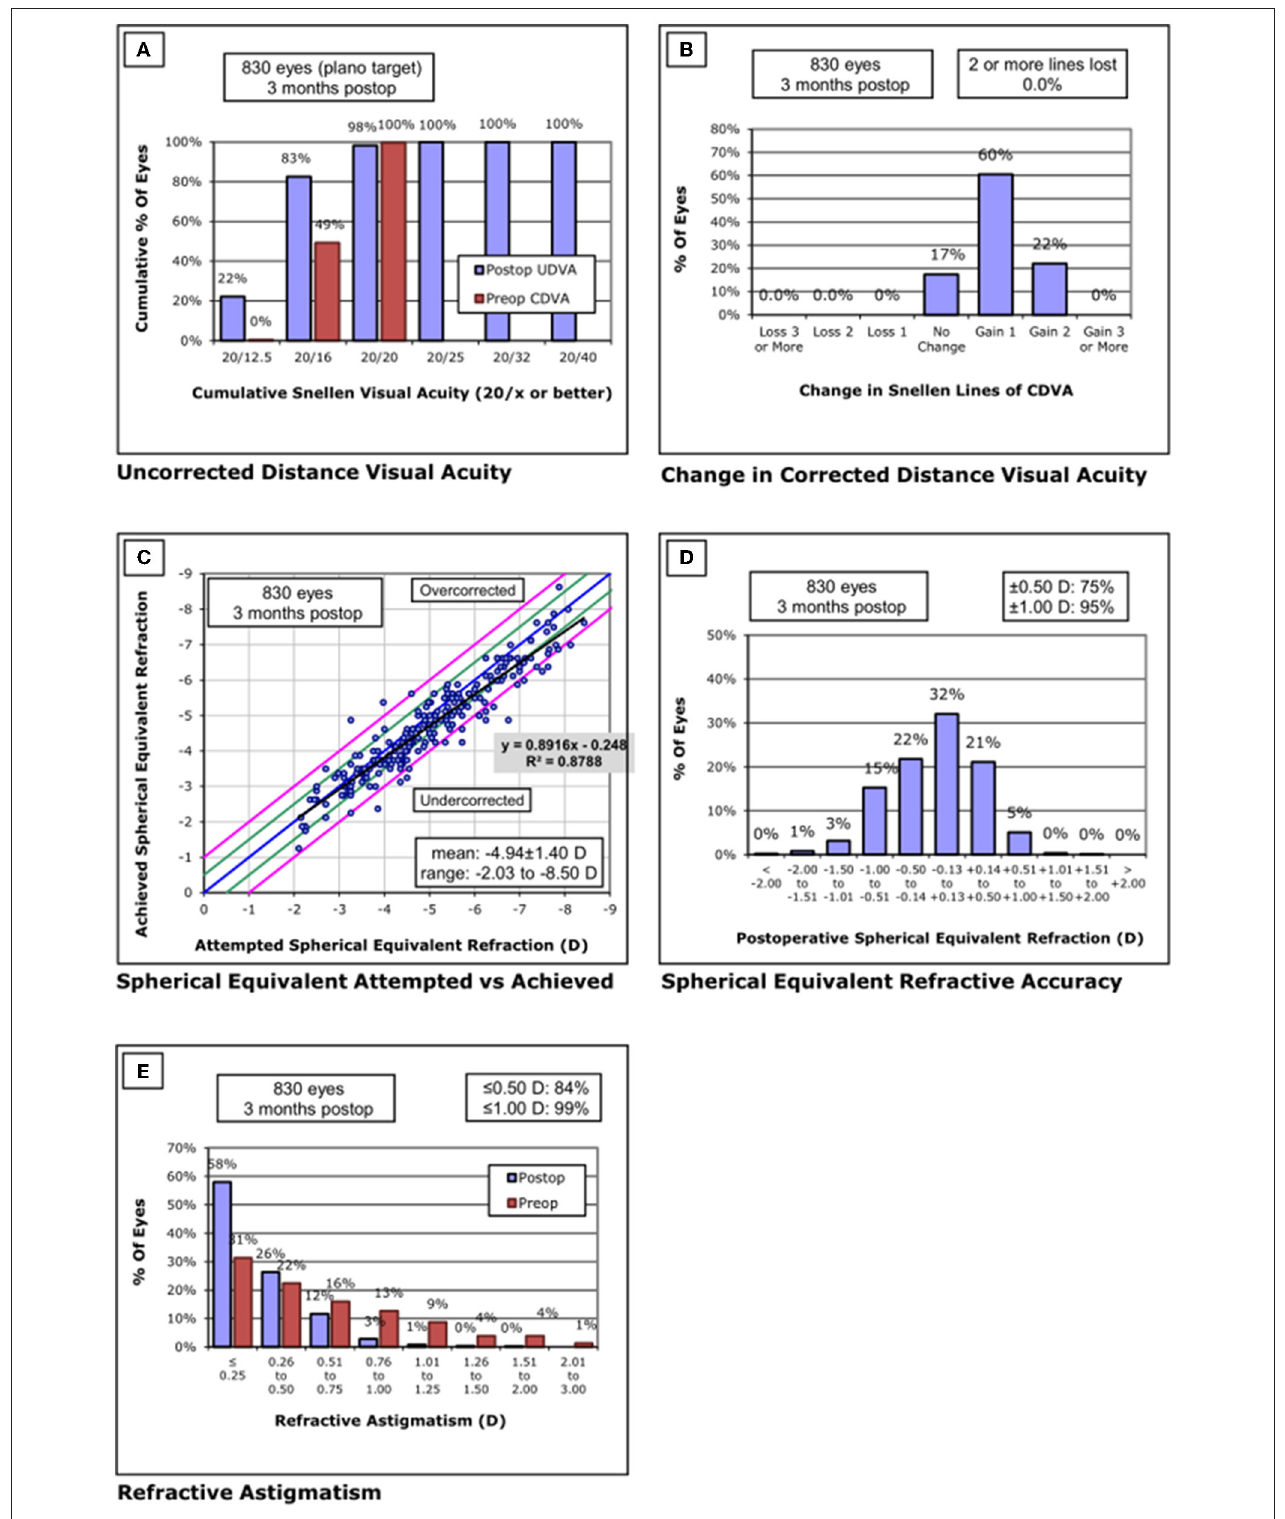
FIGURE 4 | Standard graphs of refractive surgery visual and refractive outcomes for 830 eyes at 3 months post-SMILE in center C. (A) Uncorrected distance visual acuity. (B) Change in corrected distance visual acuity. (C) Spherical equivalent attempted vs. achieved. (D) Spherical equivalent refractive accuracy. (E) Refractive astigmatism. SMILE, small-incision lenticule